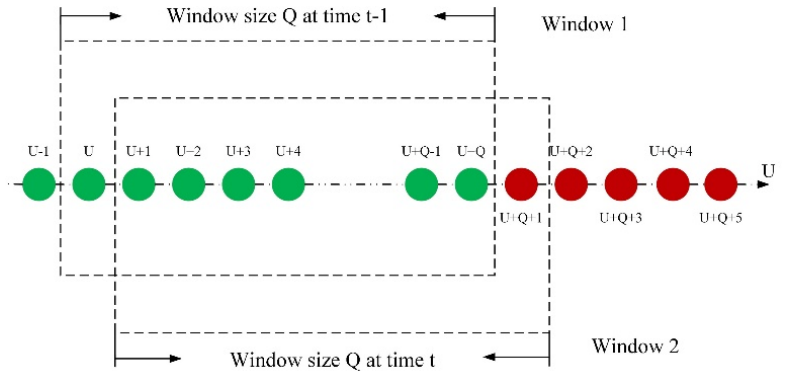
Figure 2. Sliding window model.